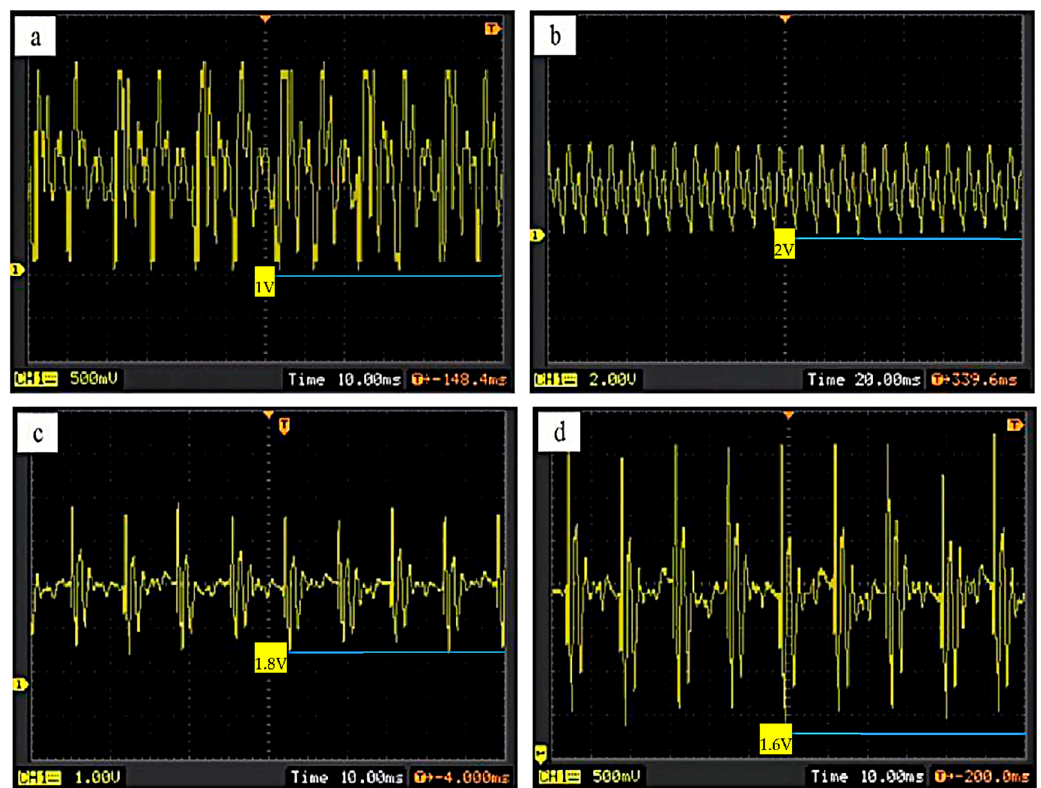
Figure 10. Piezoelectric signal of the fibers membrane at different addition of AgNO 3 : ( a ) the addition of 0.1 wt%; ( b ) the addition of 0.3 wt%; ( c ) the addition of 0.5 wt%; ( d ) the addition of 0.7 wt%. Table 4. Piezoelectric signal of the fiber membrane at different loading of AgNO 3.